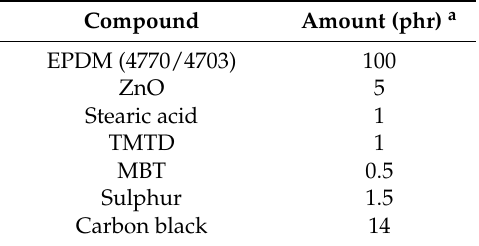
Table 1. Raw ethylene-propylene diene monomer rubber (EPDM) phase composition